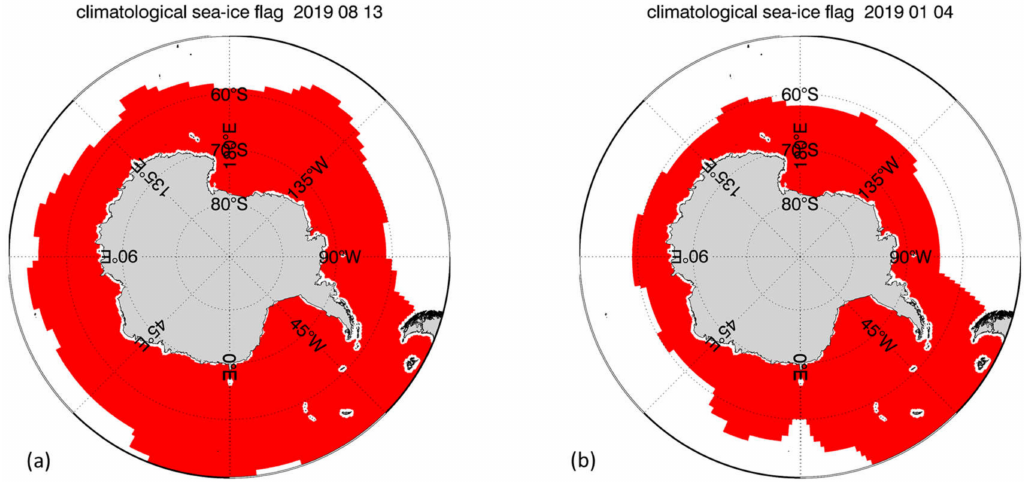
Figure 3. Climatological sea-ice masks near Antarctica for two sample days: ( a ) 13 August 2019 (Set 7-S); ( b ) 4 January 2019 (Set